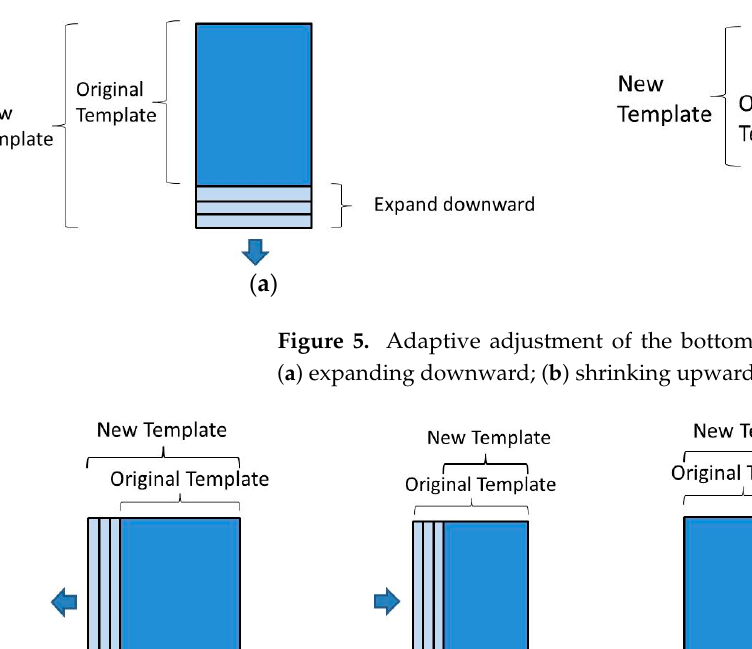
Figure 5. Adaptive adjustment of the bottom side of the template in the ADMTCF algorithm: ( a ) expanding downward; ( b ) shrinking upward.